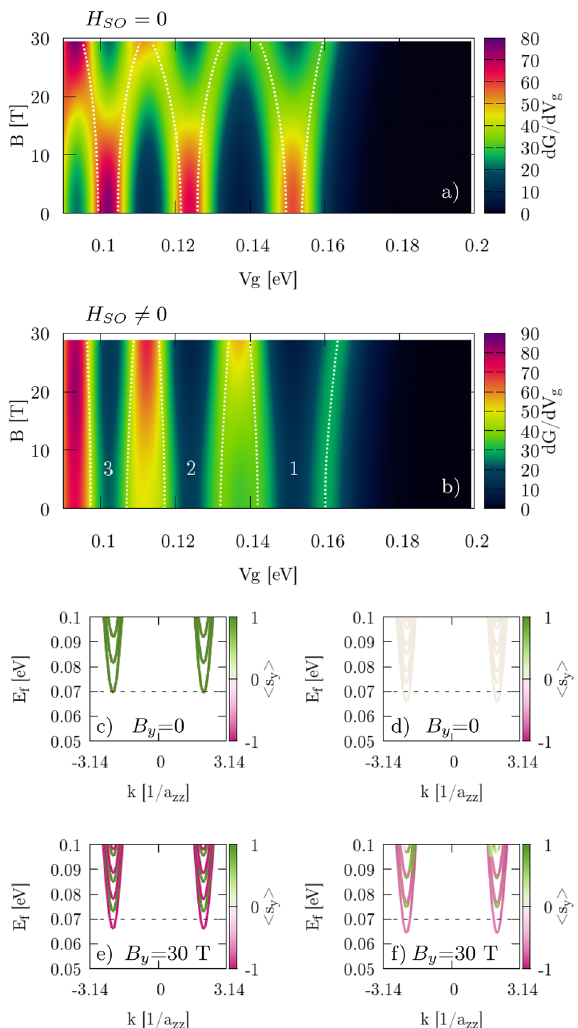
0, B , 0 orientation of the magnetic field for zigzag y = [ ]